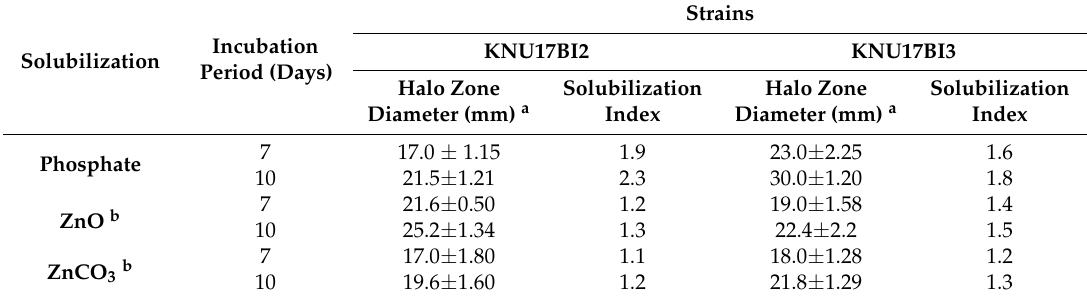
Table 2. Qualitative estimation of phosphate and zinc solubilization efficiency of the studied